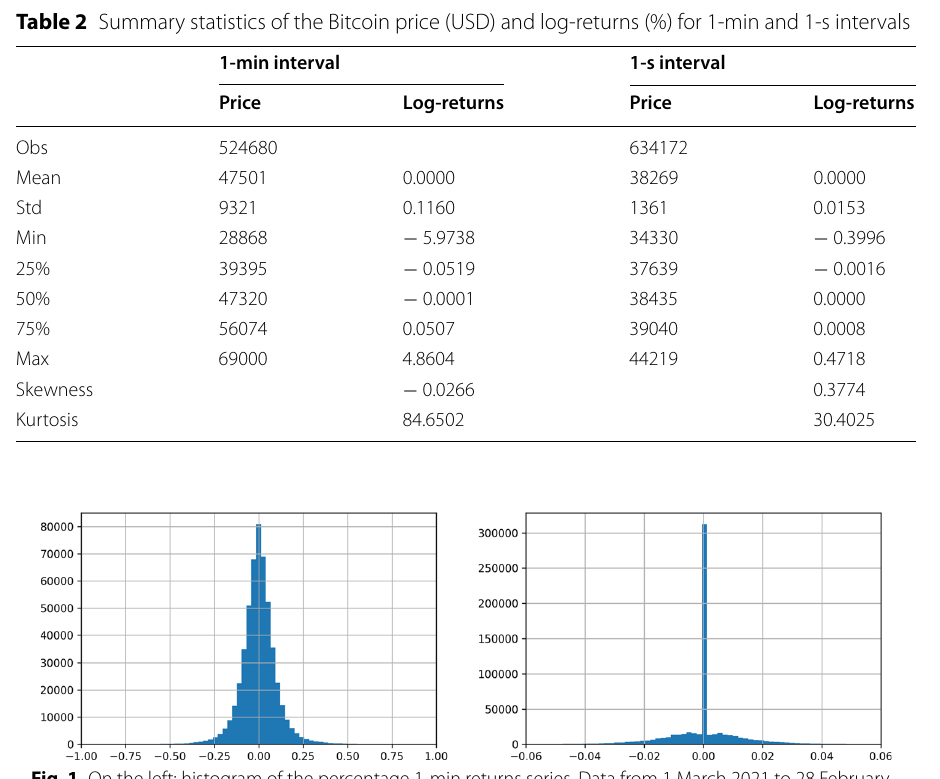
Fig. 1 On the left: histogram of the percentage 1-min returns series. Data from 1 March 2021 to 28 February 2022. The x-axis is limited between − 1 % and 1%. On the right: histogram of the percentage 1-s returns series. Data from 21 February 2021 to 28 February 2022. The x-axis is limited between -0.06% and